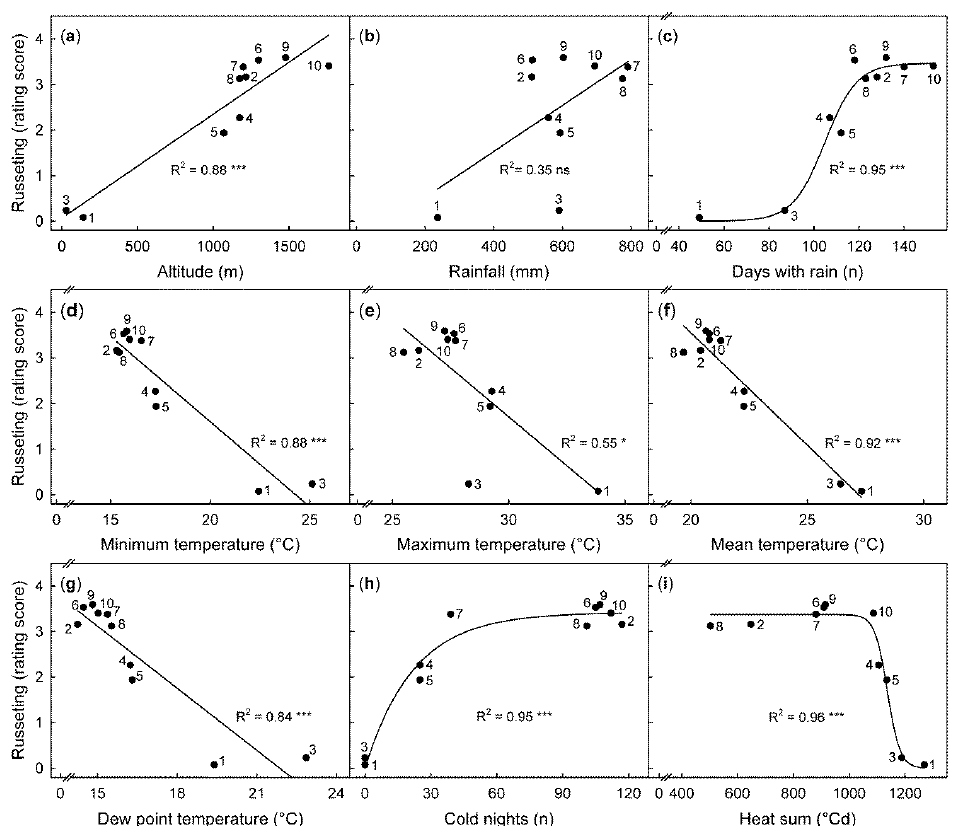
Figure 5. Relationship between climatic variables and average russeting (rating score) determined for the cumulative period of fruit maturity at ten locations in Kenya. The ten locations were: Garissa (1), Chepsigot (2), Malindi (3), Mumbuni (4), Yeemulwa (5), Kaiti (6), Kasafari (7), Kambirwa (8), Thika (9), and Machakos (10) situated at different altitudes. ( a ) The climatic variables include: rainfall amount ( b ), days with rainfall ( c ), relative humidity ( d ), minimum, maximum, and mean daily temperatures ( e , f, and g , respectively). Cold nights ( h ) correspond to the number of days when the minimum temperature fell below the base temperature of 16 °C. Heat sum ( i ) was calculated based on a base temperature of 16 °C. Russeting was quantified using a five-score rating scheme: score 0: 0% of the fruit surface area russeted; score 1: 1–10% russeted area; score 2: 11–25% russeted area; score 3: 26–50% russeted area; and score 4: 51–100% russeted area. Data points represent means of 210 fruit per site.